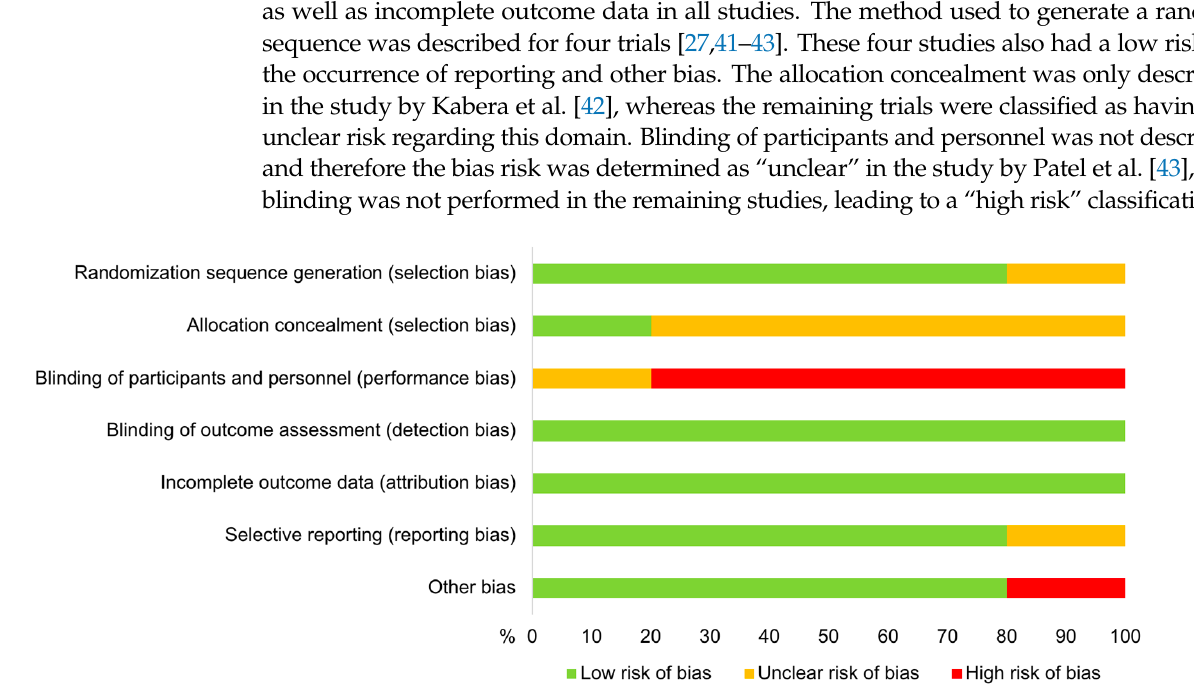
Figure 2. Risk of bias by domain of studies included in the meta-analysis evaluating the effect of selective vs. blanket dry cow treatment on the occurrence of intramammary infections and their cure during the dry period in dairy cows.